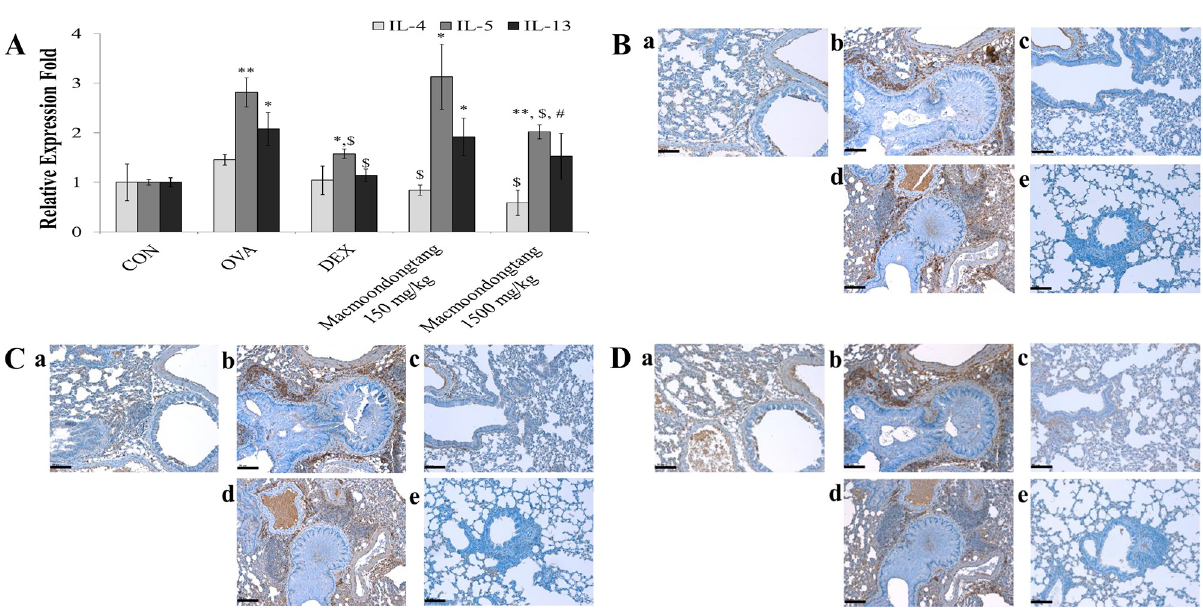
Fig 7. Macmoondongtang dose-dependently suppressed Th2-related cytokines such as IL-4, IL-5, and IL-13. Macmoondongtang significantly and effectively inhibited the gene expression of IL-5 (A) and IL-5 protein level (C). The treatment dose-dependently controlled the IL-4 protein expression (B). Similar changes at the gene (A) and protein levels of IL-13 (D) were observed as those for IL-5. a , vehicle control; b , asthma induction; c , dexamethasone; d ,150 mg/kg/day macmoondongtang ; e , 1500 mg/kg/day macmoondongtang . Each bar represents the mean ± SD (n = 8). � p < 0.05 vs. control; �� p < 0.001 vs. control; $ p < 0.05 vs. asthma induction; # p < 0.05 vs. dexamethasone. Scale Bar = 50 μ m. Magnification, × 200.